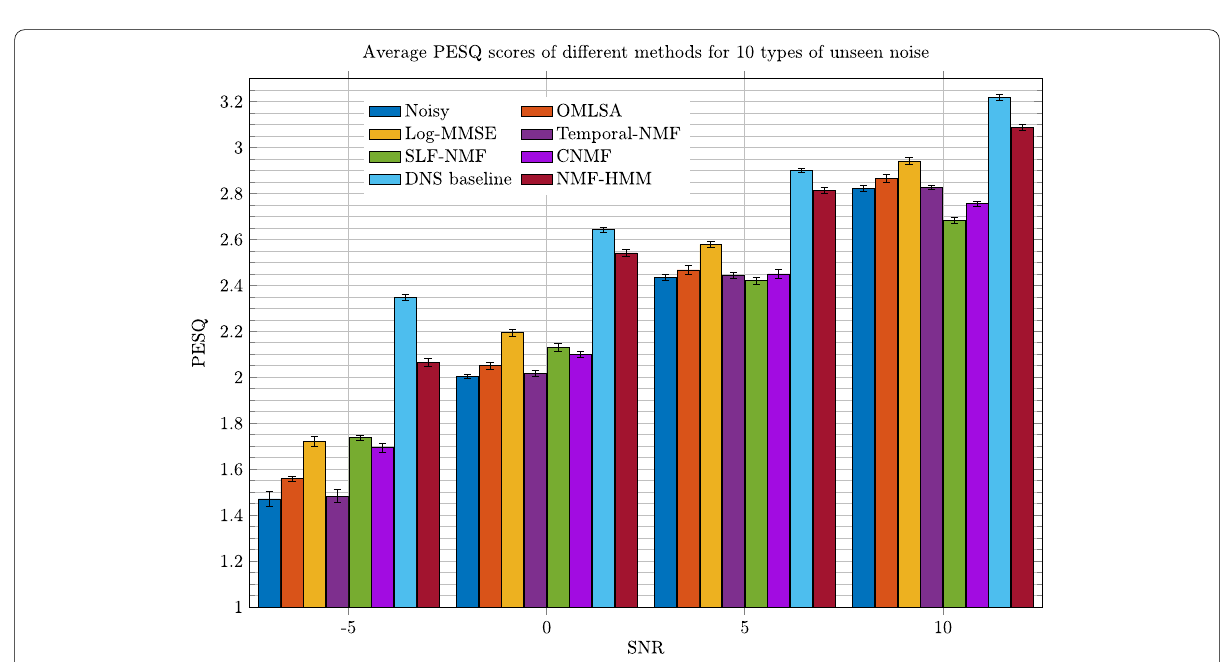
Fig. 3 Average PESQ scores of different methods for 10 types of unseen